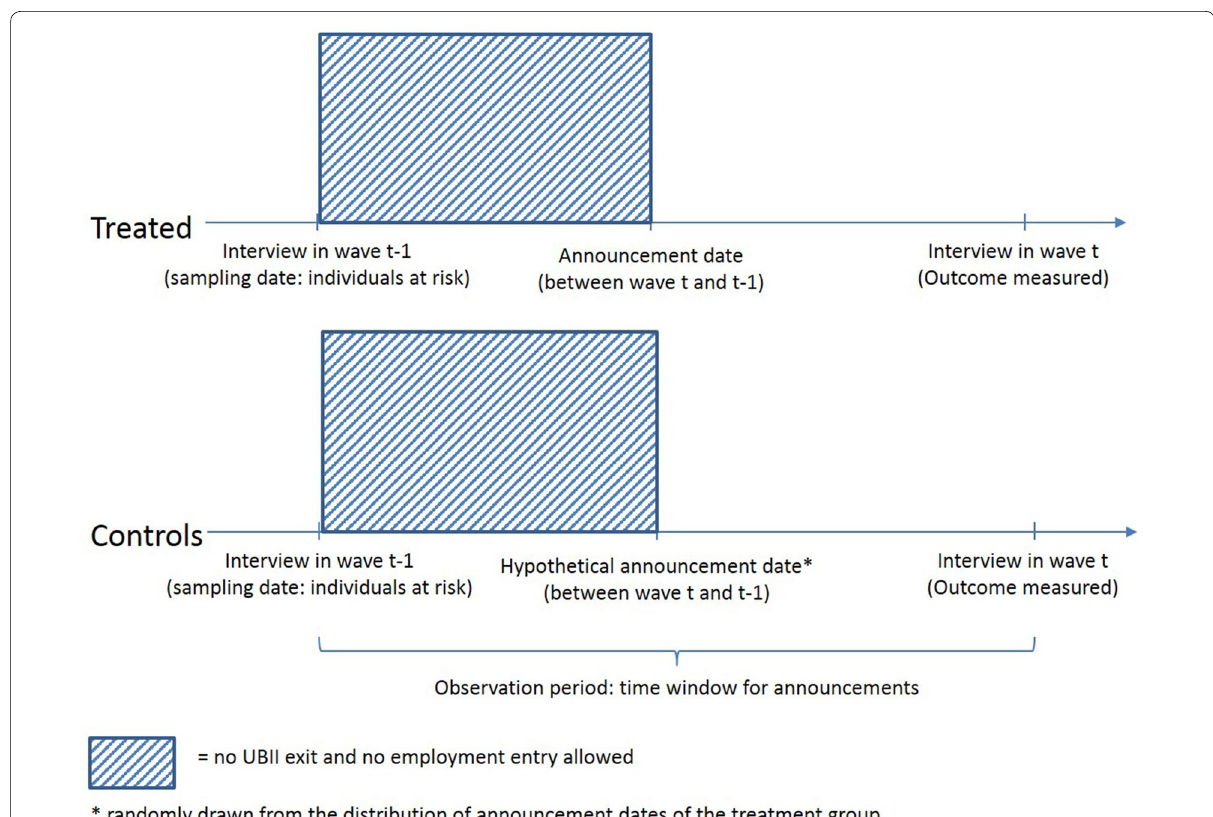
Fig. 2 Implementation of the joining or waiting